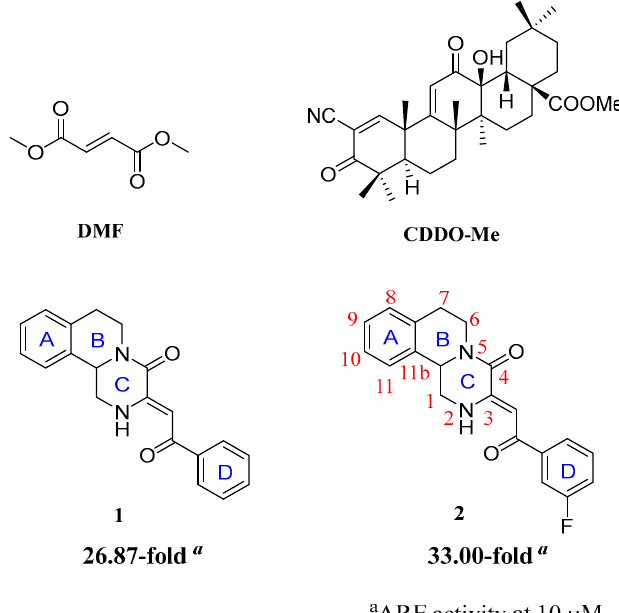
Figure 1. Structures of Dimethyl fumarate (DMF), synthetic triterpenoid bardoxolone methyl (CDDO-Me), 1 and 2 .